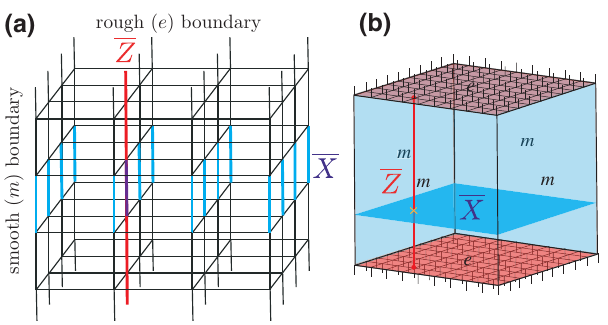
FIG. 14. The logical Z -string and the logical X -brane opera- tors are illustrated on (a) the discrete lattice and (b) the continu- ous TQFT pictures, respectively. They intersect on a single edge (purple) in the lattice picture or at a single point (yellow cross) in the TQFT picture. The dangling edges on the top and bot- tom faces (red) in (b) symbolize the rough boundaries and are sometimes omitted in the later figures for